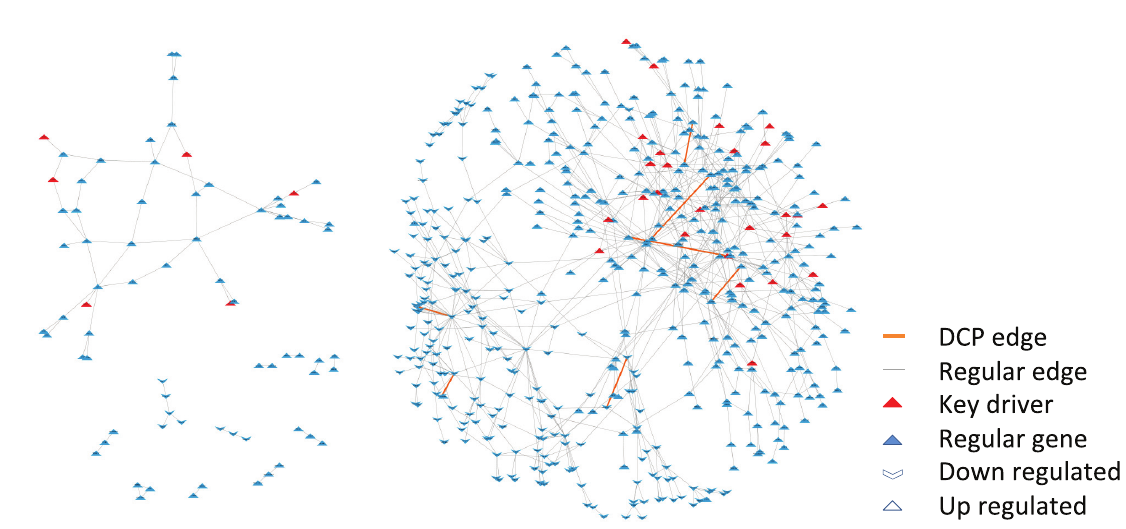
Figure 3. Co-expression networks for cervical cancer data. The nodes are composed by DEGs and the edges represent significant local partial correlation between nodes. A few causal genes (key drivers) and DCP edges are located in the high connectivity region, but scattered throughout the network. Only one key driver is amongst the genes in